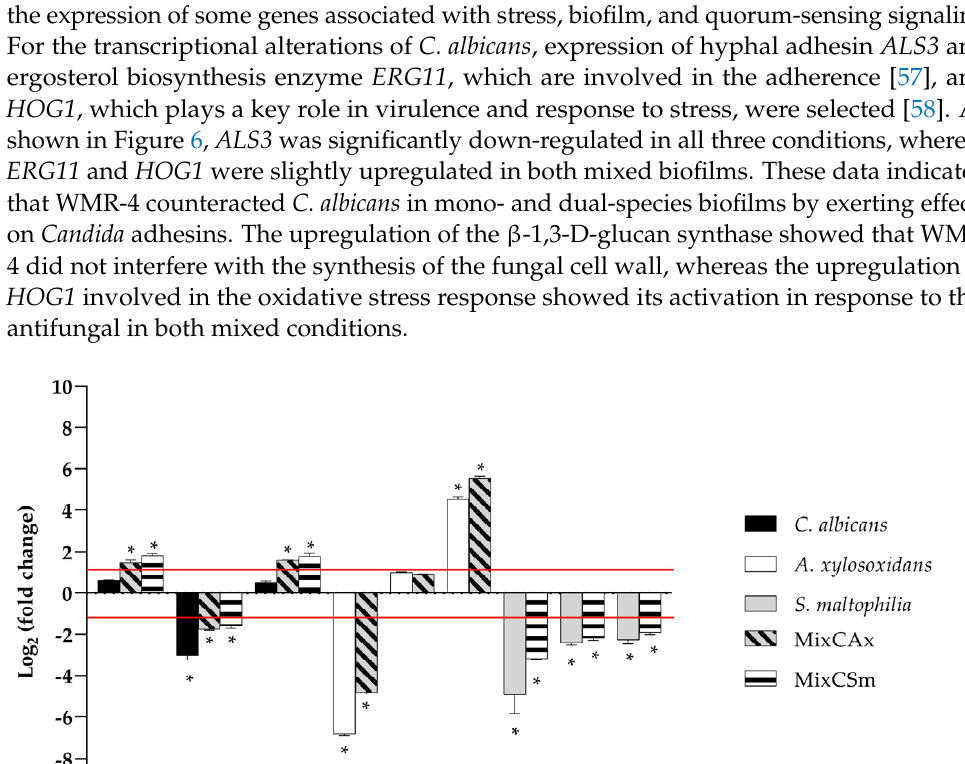
Figure 6. Real-time qPCR during inhibition of single and mixed biofilm using WMR-4 at concentration of 10 μ M. Histograms represent the fold differences in the expression levels of the genes selected during inhibition of single and mixed biofilm with WMR-4 at concentration of 10 μ M. Red lines show fold change thresholds of − 1 and +1, respectively. * = p < 0.05.